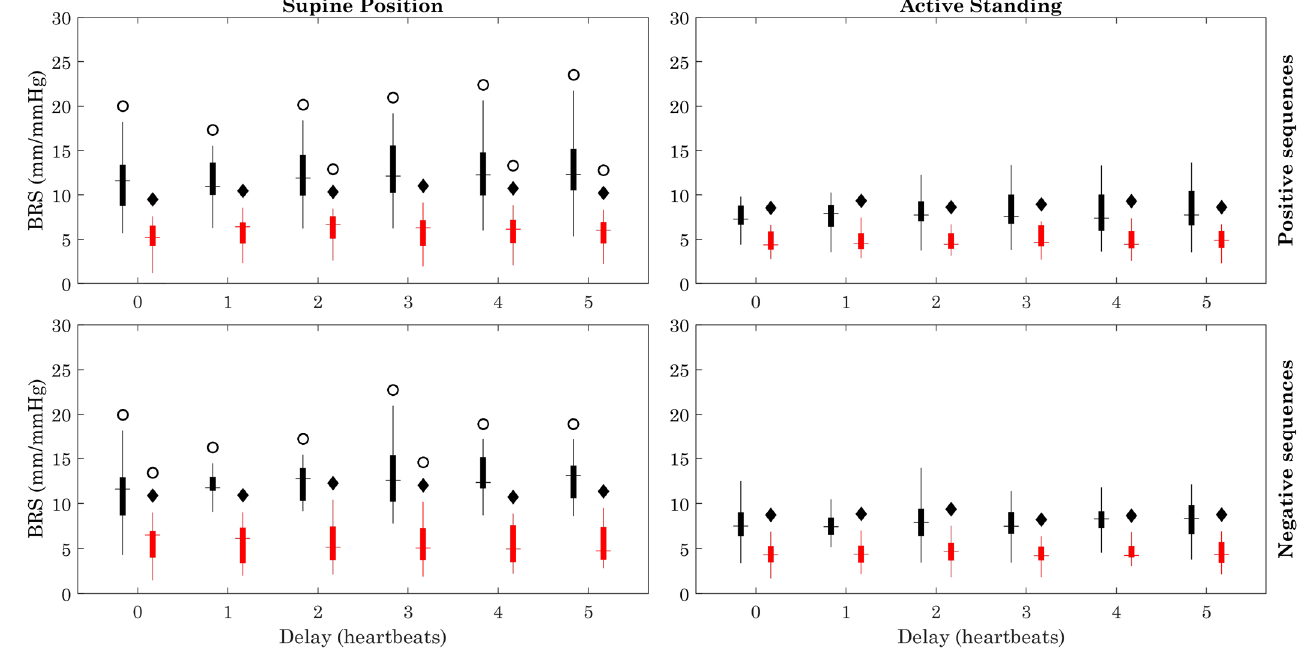
Figure 3. Baroreflex sensitivity (BRS). Figure symbology: Healthy subjects (black), ESRD patients (red). Black diamond: ESRD vs. Healthy group (within same position), p < 0.05. Open circle: Supine Position vs. Active Standing (within same group), p < 0.05.